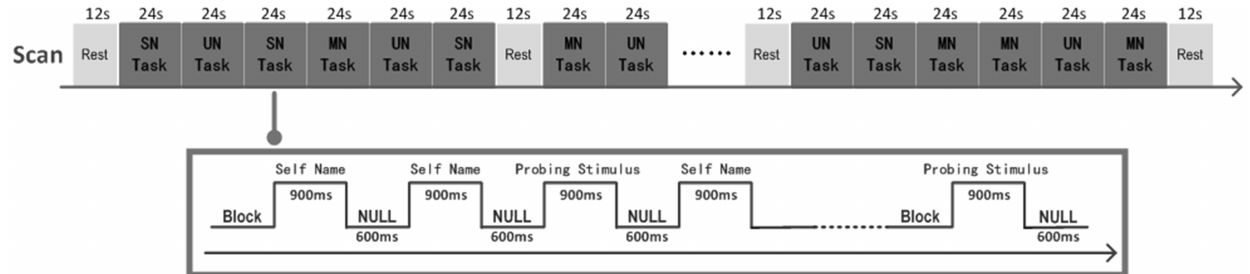
Figure 1. Schema of the design of one scan of the current study.